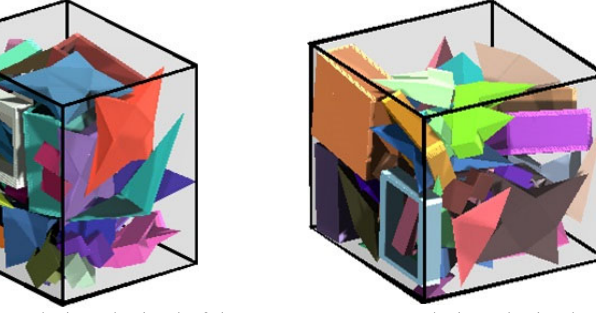
Fig. 21. Best solution obtained of the instance SGPS04 nc20 a